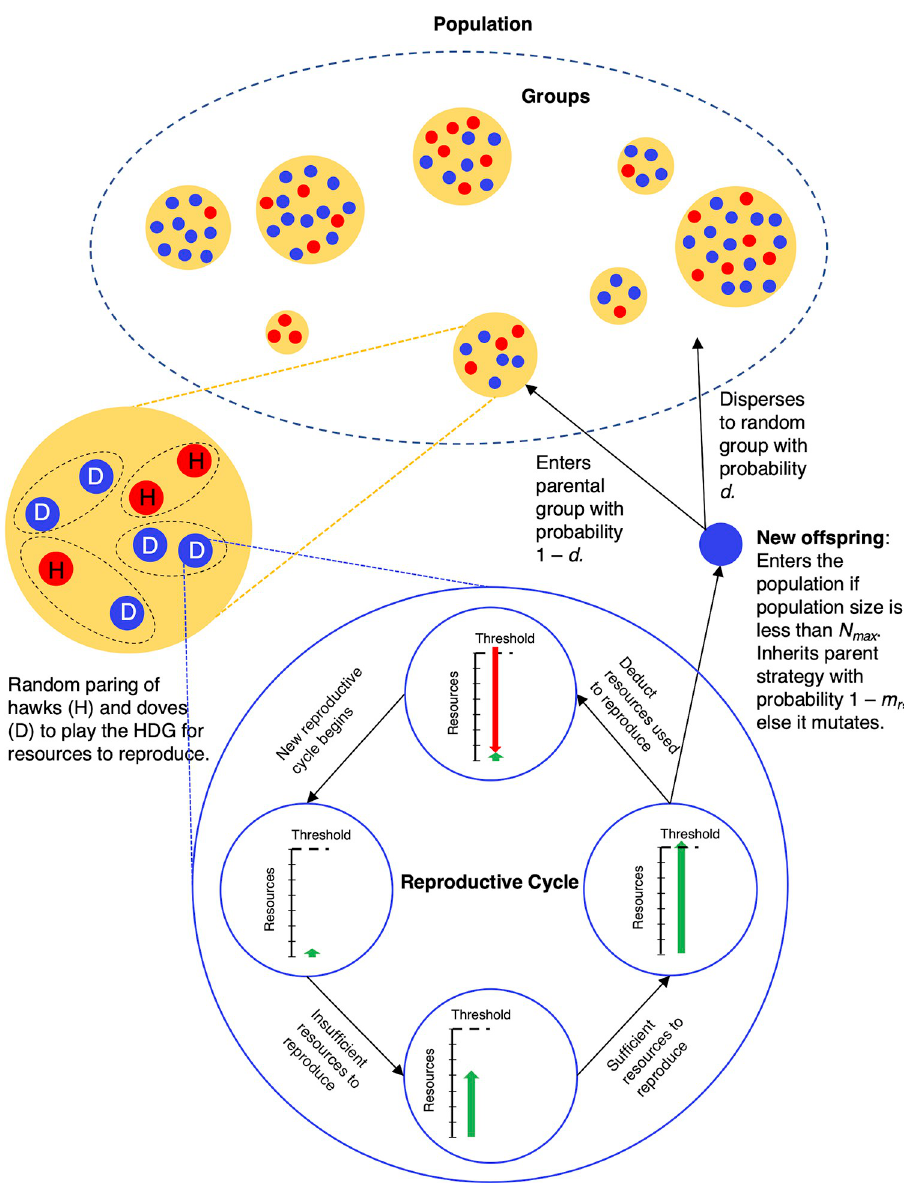
Fig 1. Overview of the model. The solid red circles indicate the hawks, and the blue circles indicate doves. Groups are shown in yellow with agents in them. The reproductive process is illustrated by a cycle illustrating the accumulation of resources and then reduction in resources when a reproductive event occurs